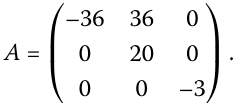
As shown in [41], a chaotic attractor (see Figure 4) is found in the incommensurate